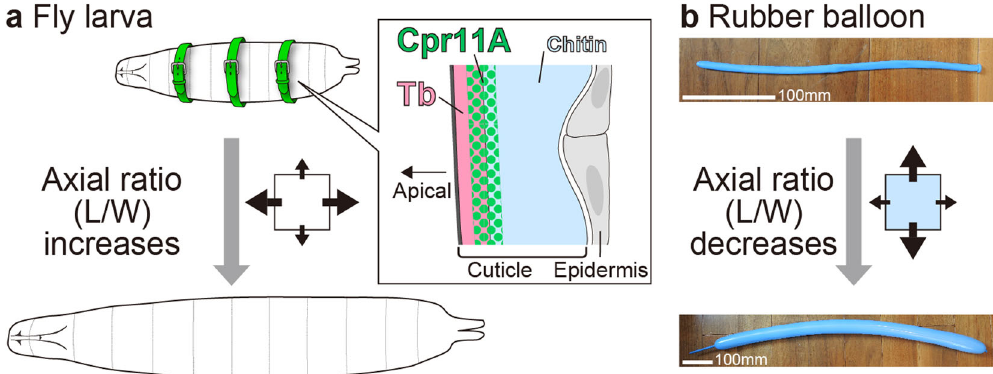
Fig. 8 A corset function of the cuticle. a A summary of this study. b A rubber balloon before (upper) and after (lower) in fl ation. In this case, the balloon expanded 3.2-fold along its longitudinal axis and 5.4-fold along its